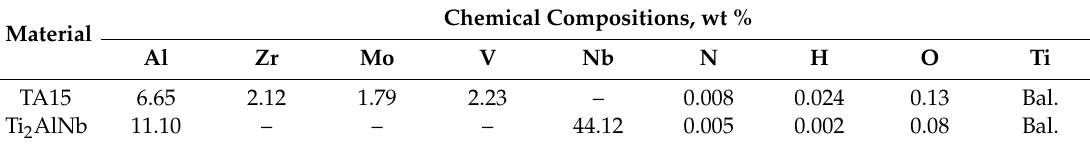
Figure 1. The SEM pictures of powder particles of TA15 and Ti 2 AlNb: ( a ) TA15; ( b ) Ti 2 AlNb. Table 1. Chemical compositions of TA15 and Ti 2 AlNb powders.